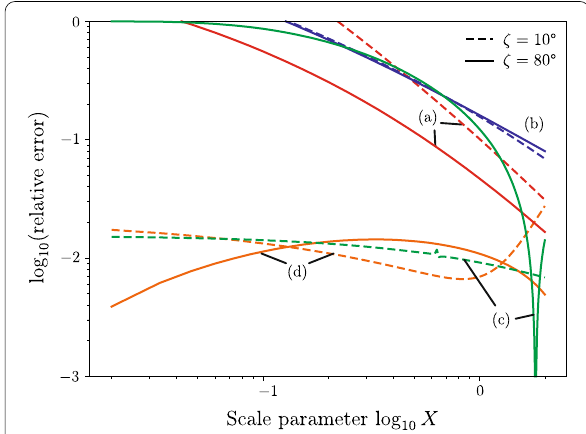
Fig. 4 Relative error as a function of the scale parameter in the 1 . The curve a corresponds to Eq. (36), the curve b asymptotic X ≤ stems from the Kocifaj result (Kocifaj 1996), the curve c is due to Green and Barnum (1963), and the curve d is obtained from Eq. (43). The cases of small (dashed) and large (solid) solar zenith angles are